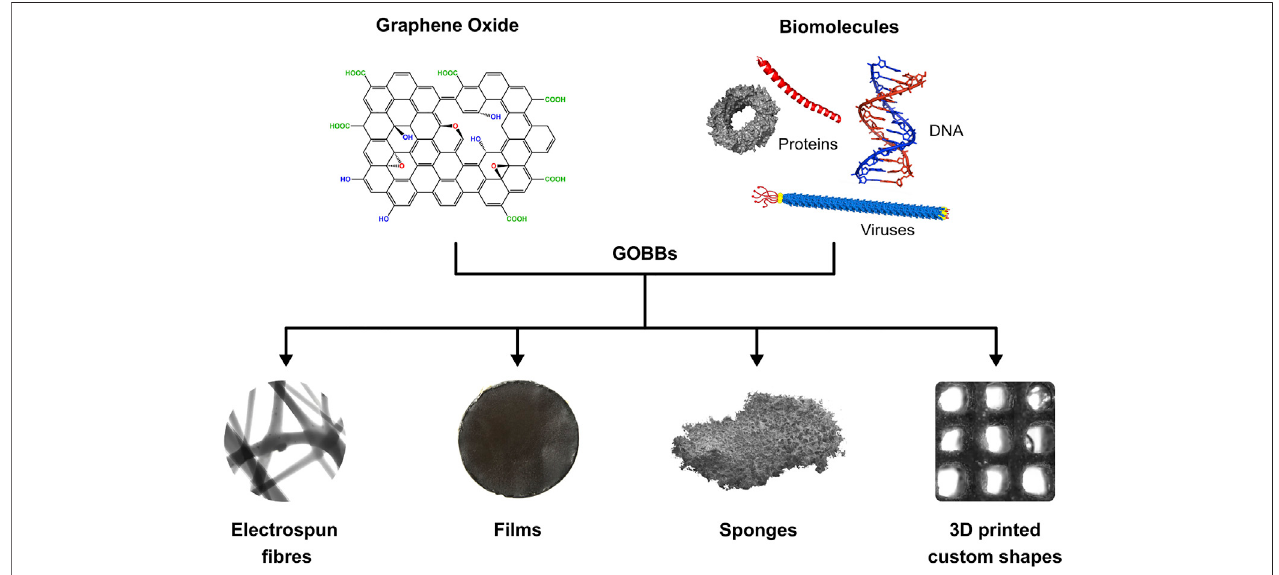
FIGURE 2 | Schematic of GOBBs assembly GO and biomolecules can be combined to form GOBBs presenting different 3D structures such as fi bres, fi lms, sponges and 3D printed custom shapes.